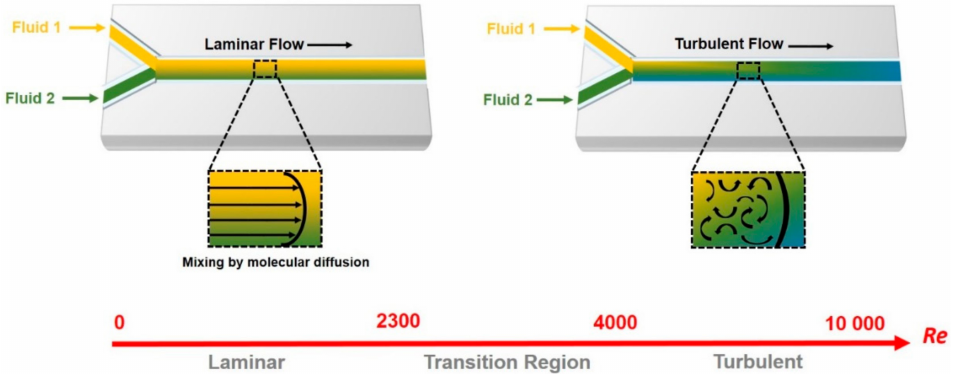
Figure 1. Schematic showing the laminar and turbulent flow. The Reynolds number (Re) describes the physical characteristics of the fluid flow in microfluidic channels. In laminar flow (Re < 2300), the two streams move in parallel to the flow direction and mixed based on the diffusion ( Left ). In turbulent flow (Re > 4000), fluids move in all three-dimensions without correlation with the flow direction ( Right ). The transition region (2300 < Re < 4000) shares the features of laminar and turbulent